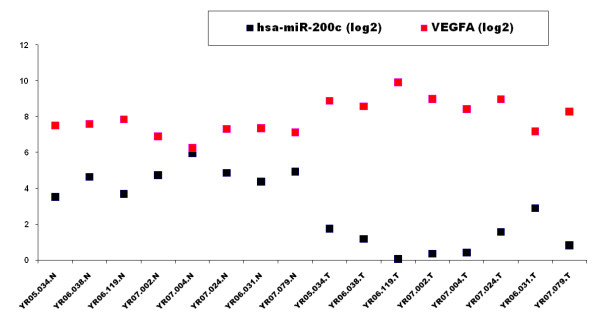
Anti-correlation of microRNA expression and predicted target mRNA. Expression levels of miR-200c and VEGFA in the primary dataset showing anti-correlation in both ccRCC and matched normal kidney tissue. This plot suggests that loss of miR-200c function in ccRCC contributes to increase in VEGF levels.